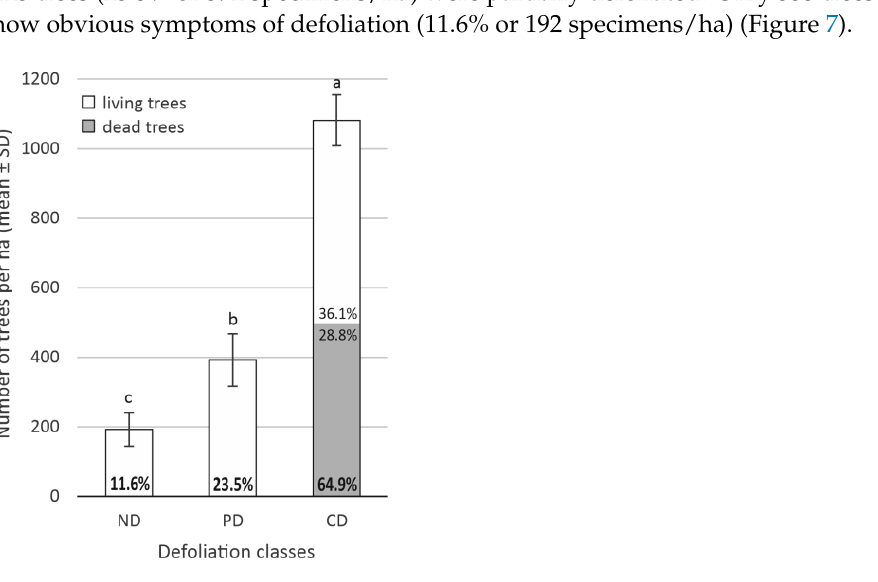
Table 4. Summary statistics for differences between number of trees per hectare depending on the defoliation class (ANOVA one way).